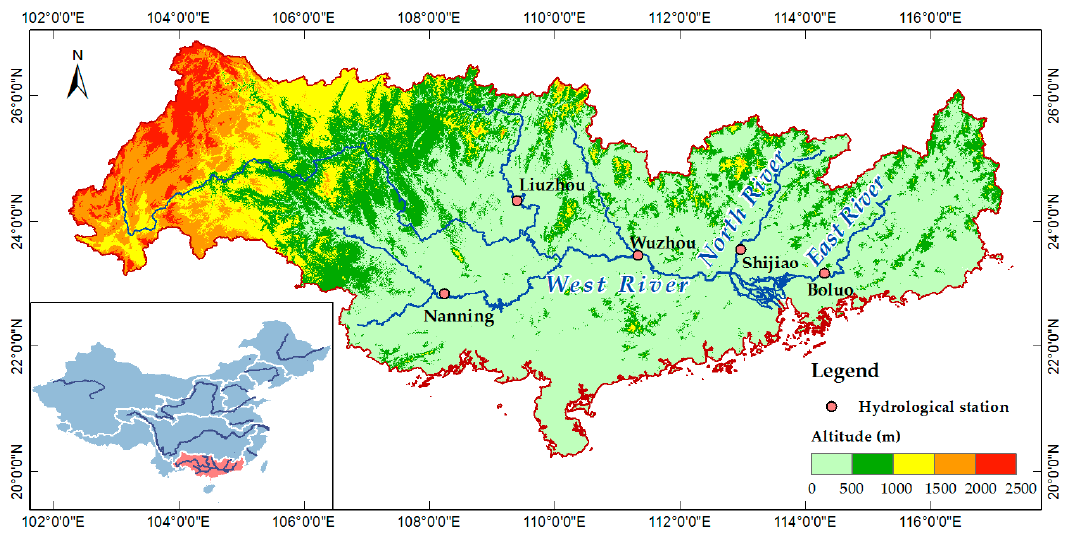
Figure 1. Topography of the Pearl River Basin and location of the main hydrological control stations.